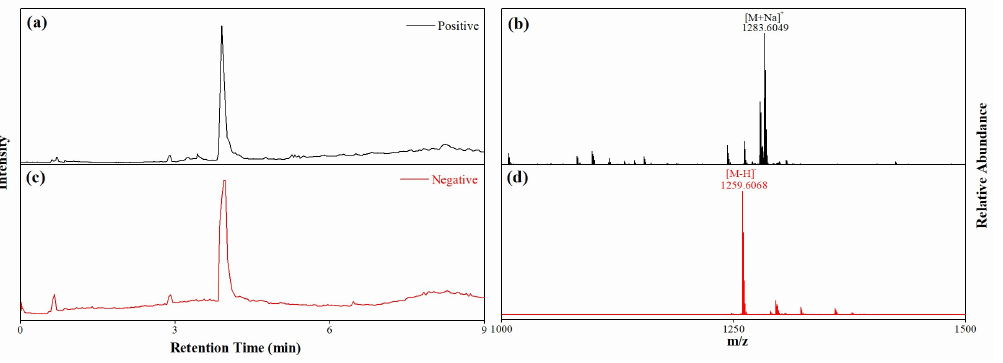
Figure 2. Chromatograms and exact masses of Compound 1 in positive ( a , b ) and negative ( c , d ) modes.